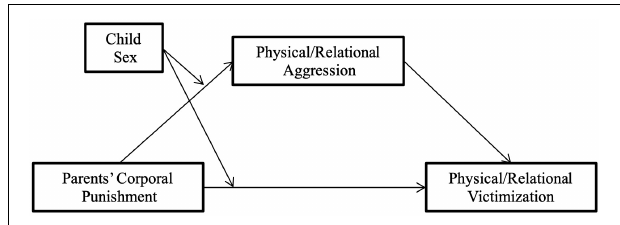
FIGURE 1 | The summarized conceptual model of moderated mediation.